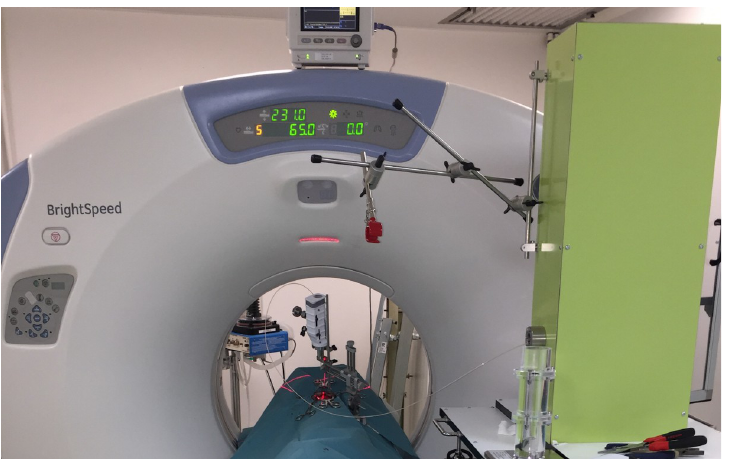
Fig 1. Preclinical injection system developed by EVEON. The injector is located beside the operation table in CT room. The injection needle is connected to the injector through a connection tube to transfer the Ho suspension from the injector to the